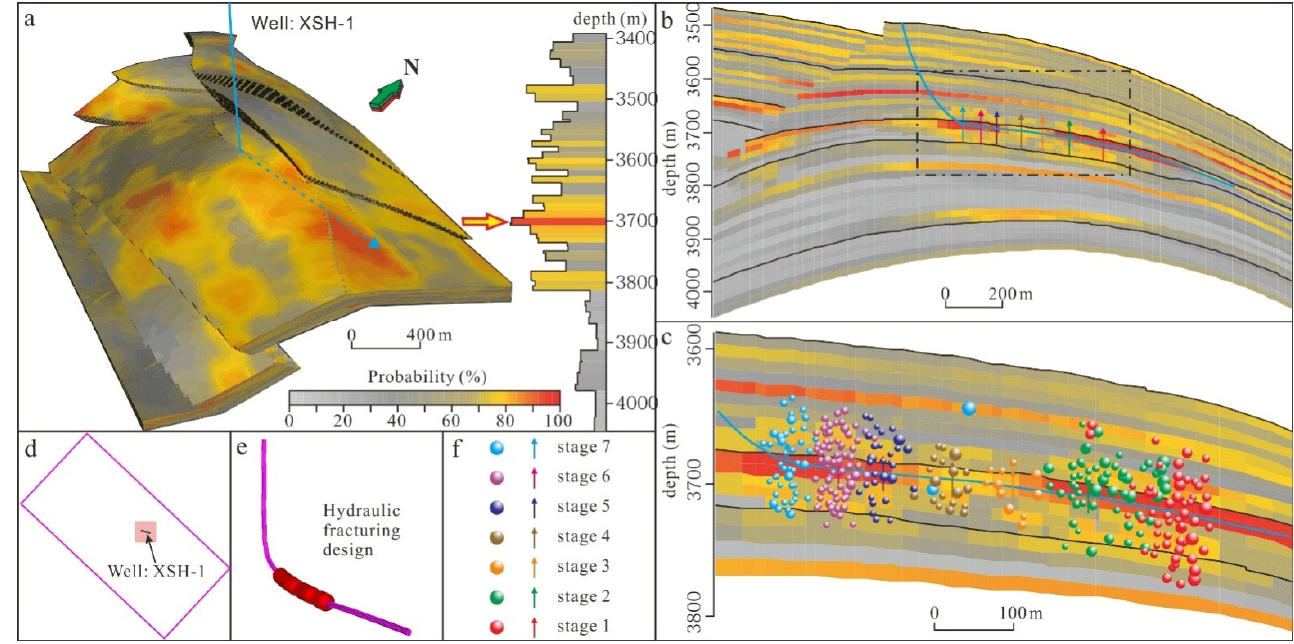
Figure 6. The micro-seismic monitoring data and lithology probability model of a stimulated hori- zontal well: ( a ) The 3D probability model of the distribution of good reservoirs; ( b ) profile of the probability model; ( c ) micro seismic event points of the hydraulic fracture, enlargement of the dashed outlined-box in ( b ); ( d ) well location; ( e ) well trajectory and hydraulic fracturing design; ( f ) the micro seismic event and fracturing location of each stage (indicated by the colored balls and arrows, the size of the ball indicating the strength of the seismic event in ( c )).